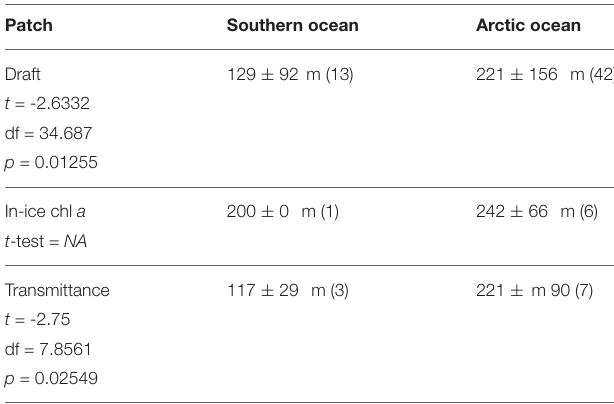
TABLE 8 | Summary of the patch size for total thickness, transmittance and in-ice chl a as result of the spatial autocorrelation analysis (section